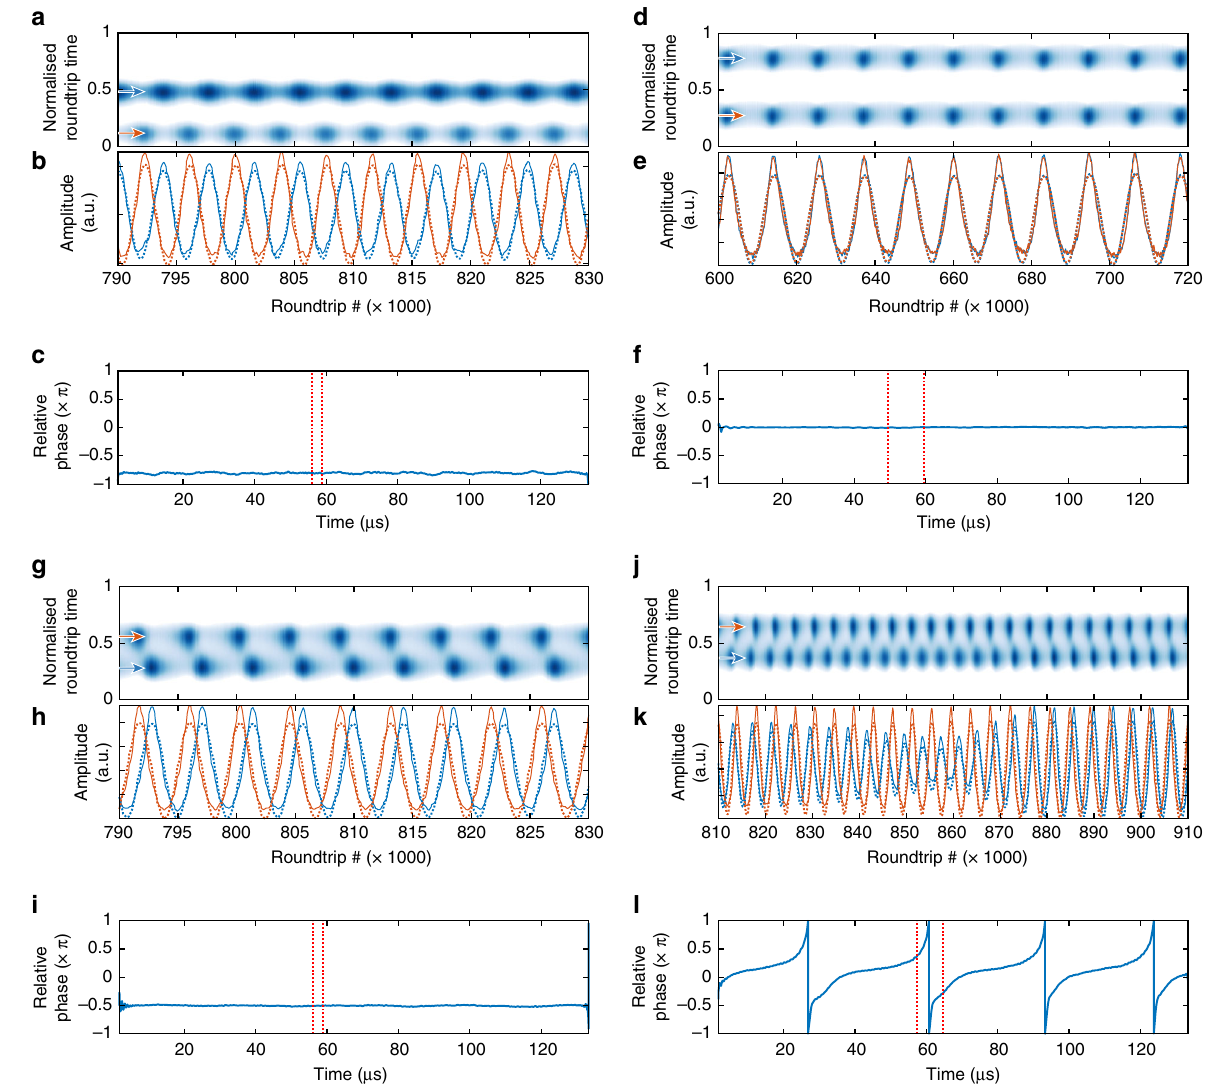
Fig. 8 Relative breathing phase. Four realisations are presented. a , d , g , j Expose the spatiotemporal map of a fraction of the trace. The blue and red curves of b , e , h , k display the evolution of the amplitude of each soliton. The plain ( dashed ) lines show the raw ( fi ltered ) signals. c , f , i , l Show the evolution of the relative breathing phase across the entire trace. The dashed red interval marks the section of the trace displayed in the two panel above. Upon various two breathing soliton state realisations, the relative breathing phase is observed to vary. a – c Out-of-phase breathing. d – f In-phase breathing. g – i Quadrature breathing. j – l At the breathing onset, the phase continuously accumulates but the breathing tends to synchronise when close to in